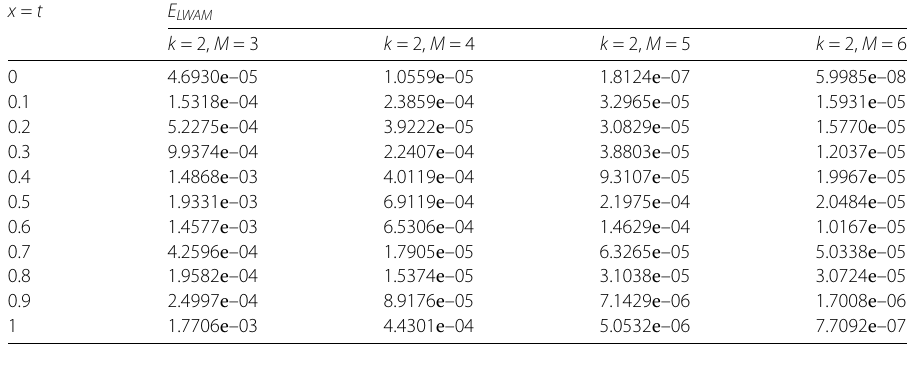
Table 2 Absolute errors for N = 8, different values of M , α = 1 in Example 1